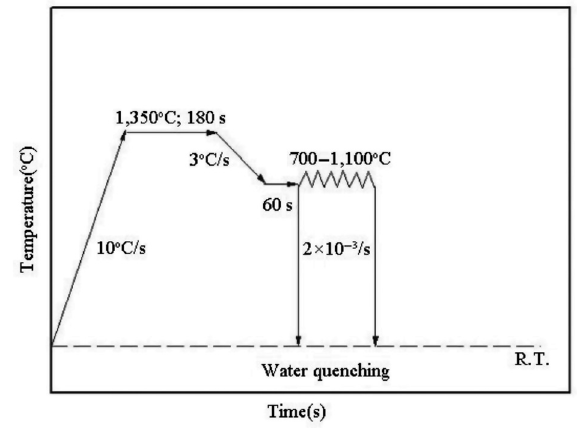
Figure 2: The thermomechanical cycle for hot tensile test.